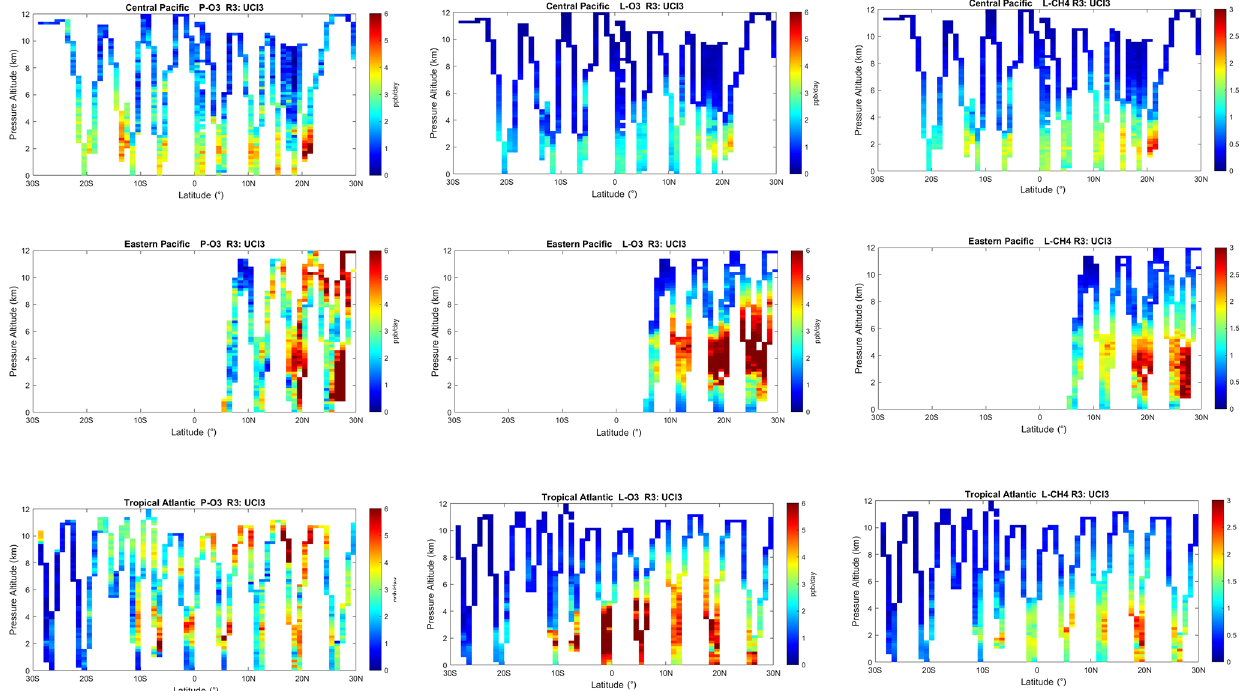
Figure 2. Curtain plots for P-O3 (0–6ppb/d), L-O3 (0–6ppb/d) and L-CH4 (0–3ppb/d) showing the profiling of ATom-1 flights in the central Pacific (RF 3, 4 and 5), eastern Pacific (RF 1) and Atlantic (RF 7, 8 and 9). Reactivities are calculated with the UCI model using MDS-2 and the new RDS ∗ protocol (UCI RDS ∗ -2). The 10s air parcels are averaged into 1 ◦ latitude and 200m altitude